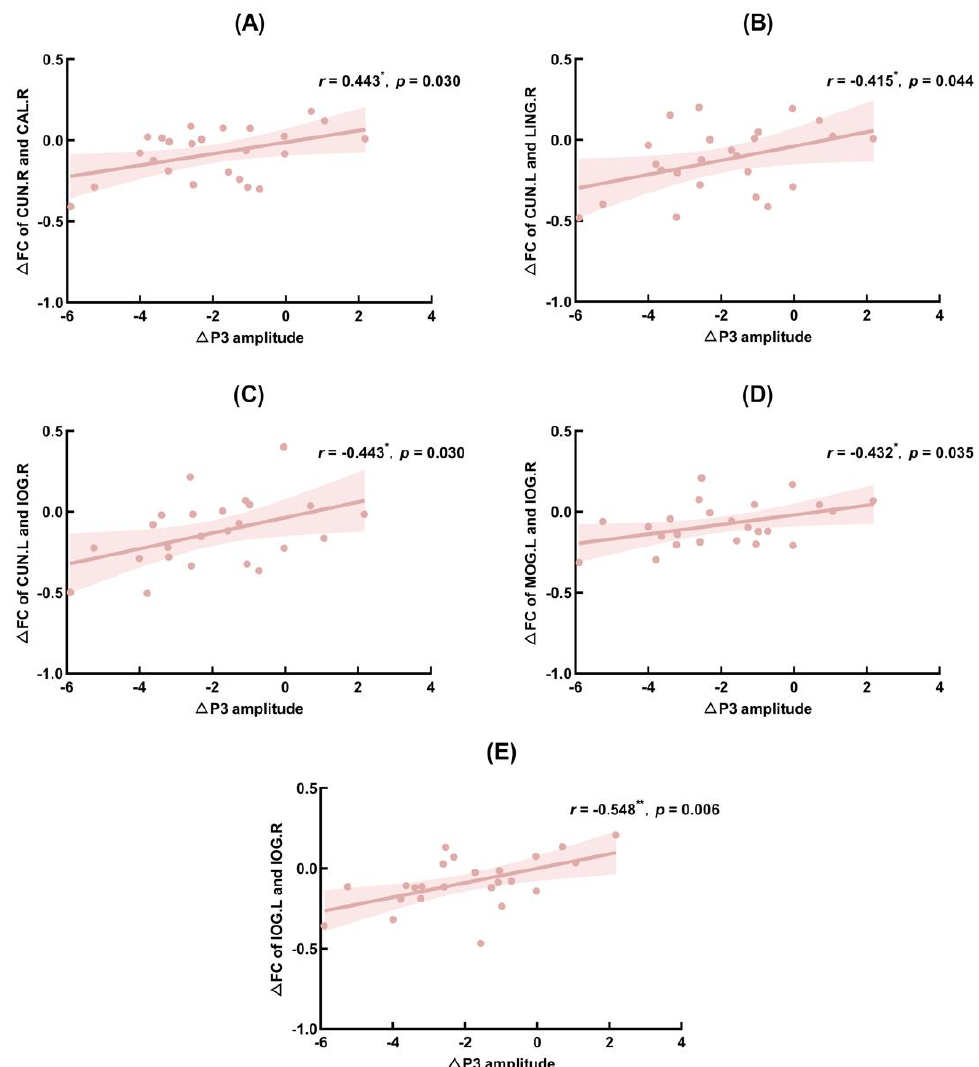
Figure 8. Significant correlation between functional connectivity (FC) changes and P3 amplitude changes. MOG.L: left middle occipital gyrus; IOG.R: right inferior occipital gyrus; CUN.L: left cuneus; CUN.R: right cuneus; CAL.R: right calcarine fissure surrounding cortex; LING.R: right lingual gyrus; IOG.L: left inferior occipital gyrus. ( A ): Correlation between ∆ FC of CUN.R and CAL.R and ∆ P3 amplitude; ( B ): Correlation between ∆ FC of CUN.L and LING.R and ∆ P3 amplitude; ( C ): Correlation between ∆ FC of CUN.L and IOG.R and ∆ P3 amplitude; ( D ): Correlation between ∆ FC of MOG.L and IOG.R and ∆ P3 amplitude; ( E ): Correlation between ∆ FC of IOG.L and IOG.R and ∆ P3 amplitude. *: p < 0.05; **: p < 0.01.